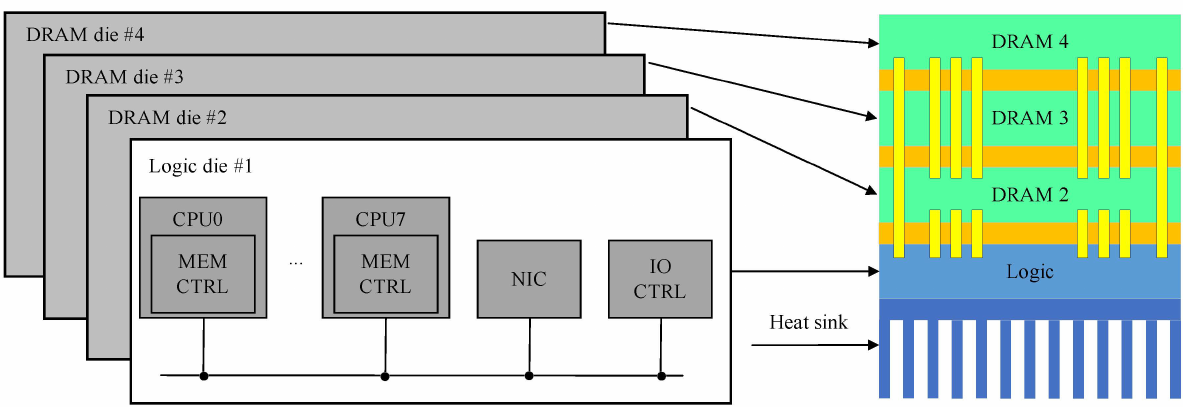
Figure 6. A diagram depicting the PicoServer (reprinted from Ref. [43], Copyright 2006, with permission from